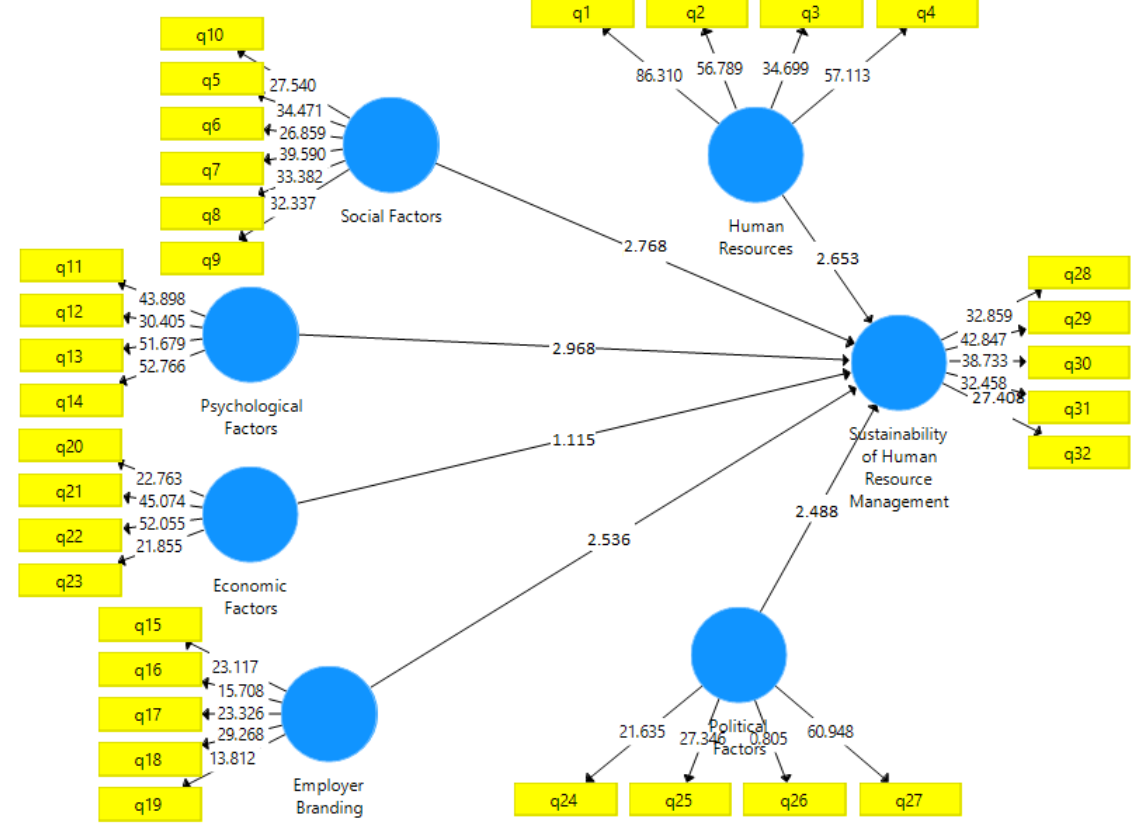
Figure 2. t-values (Source: